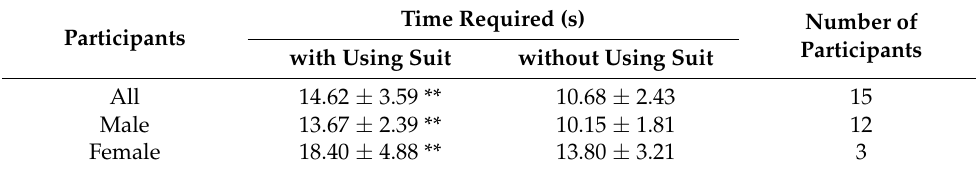
Table 4. Average time for one round trip at the first use of the power assist